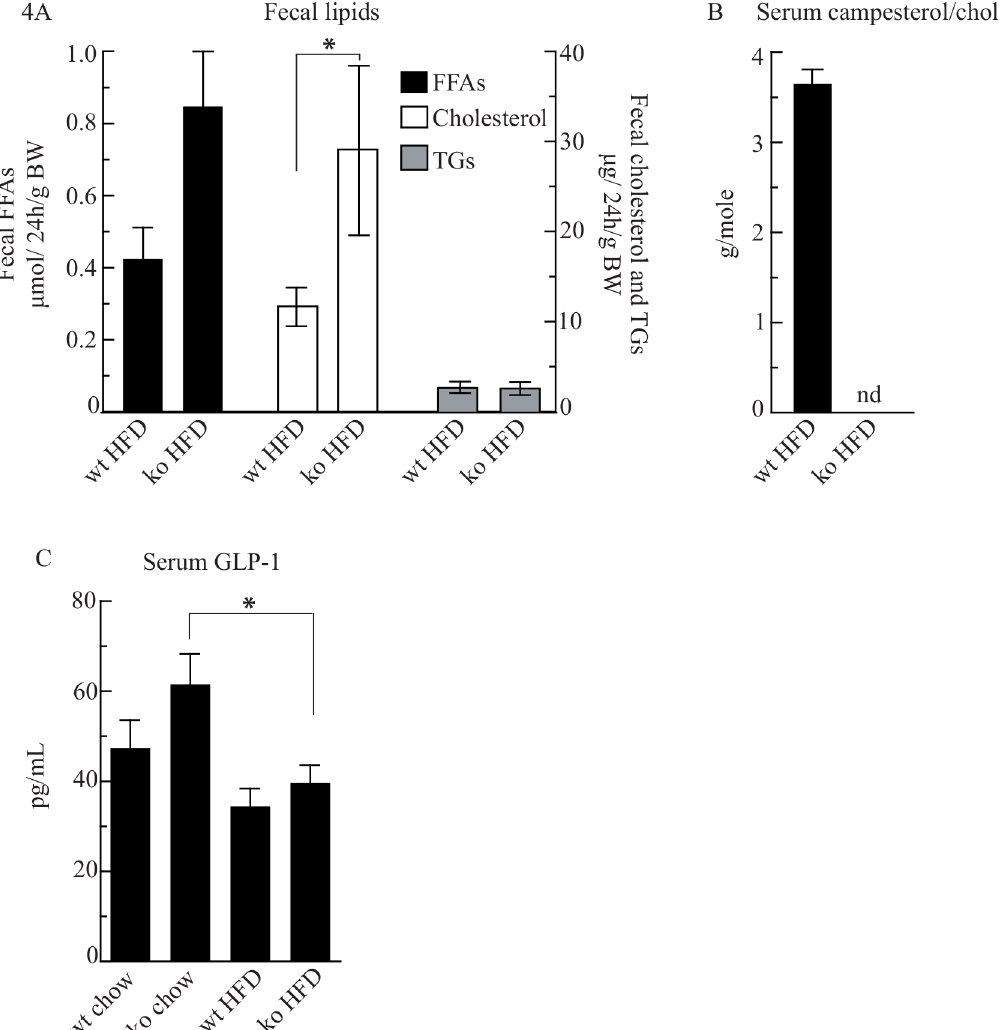
Fig 4. Cyp8b1 -/- (ko) mice have increased fecal excretion of cholesterol and free fatty acids (FFAs) when fed a high fat diet (HFD) as compared to Cyp8b1 +/+ (wt) mice. Fecal excretion of FFAs, cholesterol, and triglycerides (A) , serum campesterol levels, a marker of cholesterol absorption (B) , and serum glucagon-like peptide-1 (GLP-1) levels (C) . Where indicated, data is shown as mean ± SEM, n = (17 – 19) for all groups. *** = p < 0.001, ** = p < 0.01, and * = p <